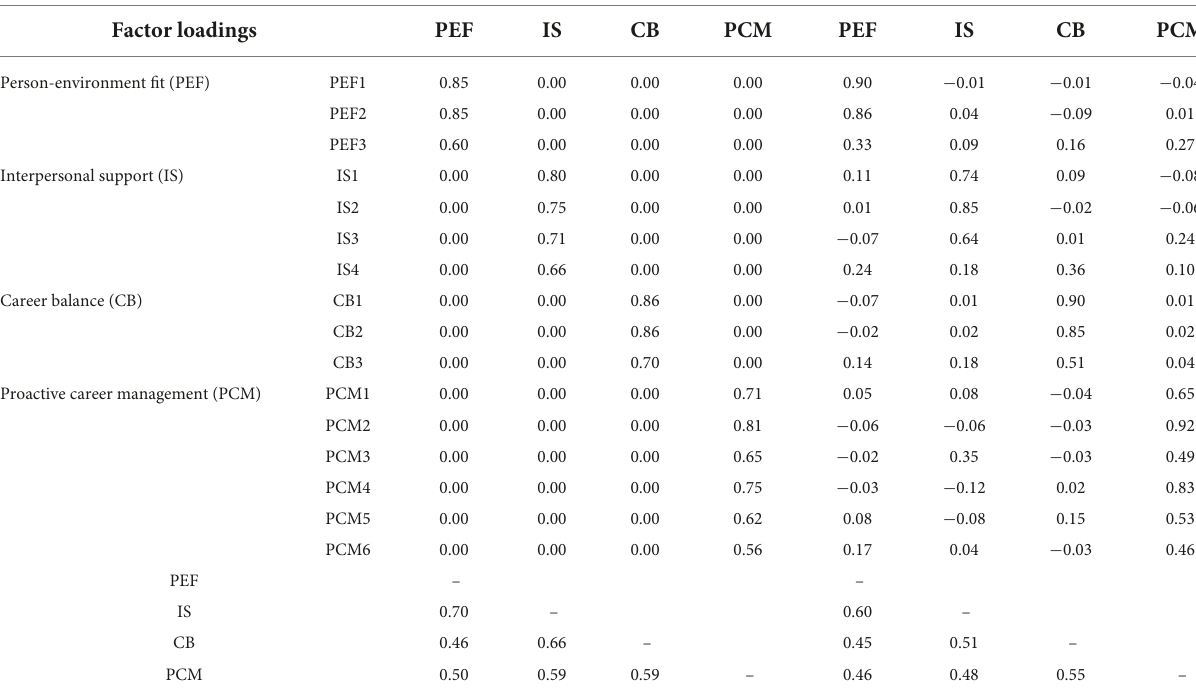
TABLE 6 CFA and ESEM